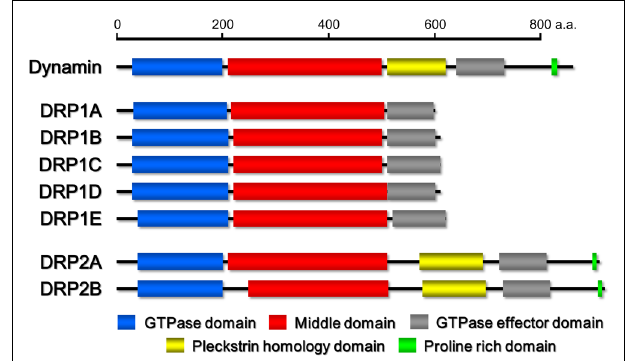
FIGURE 1 | Schematic drawings of the domain organizations of Homo sapiens dynamin and Arabidopsis thaliana DRP1 and DRP2 family members. The domains were identified by the pfam program (http://pfam.sanger.ac.uk/).